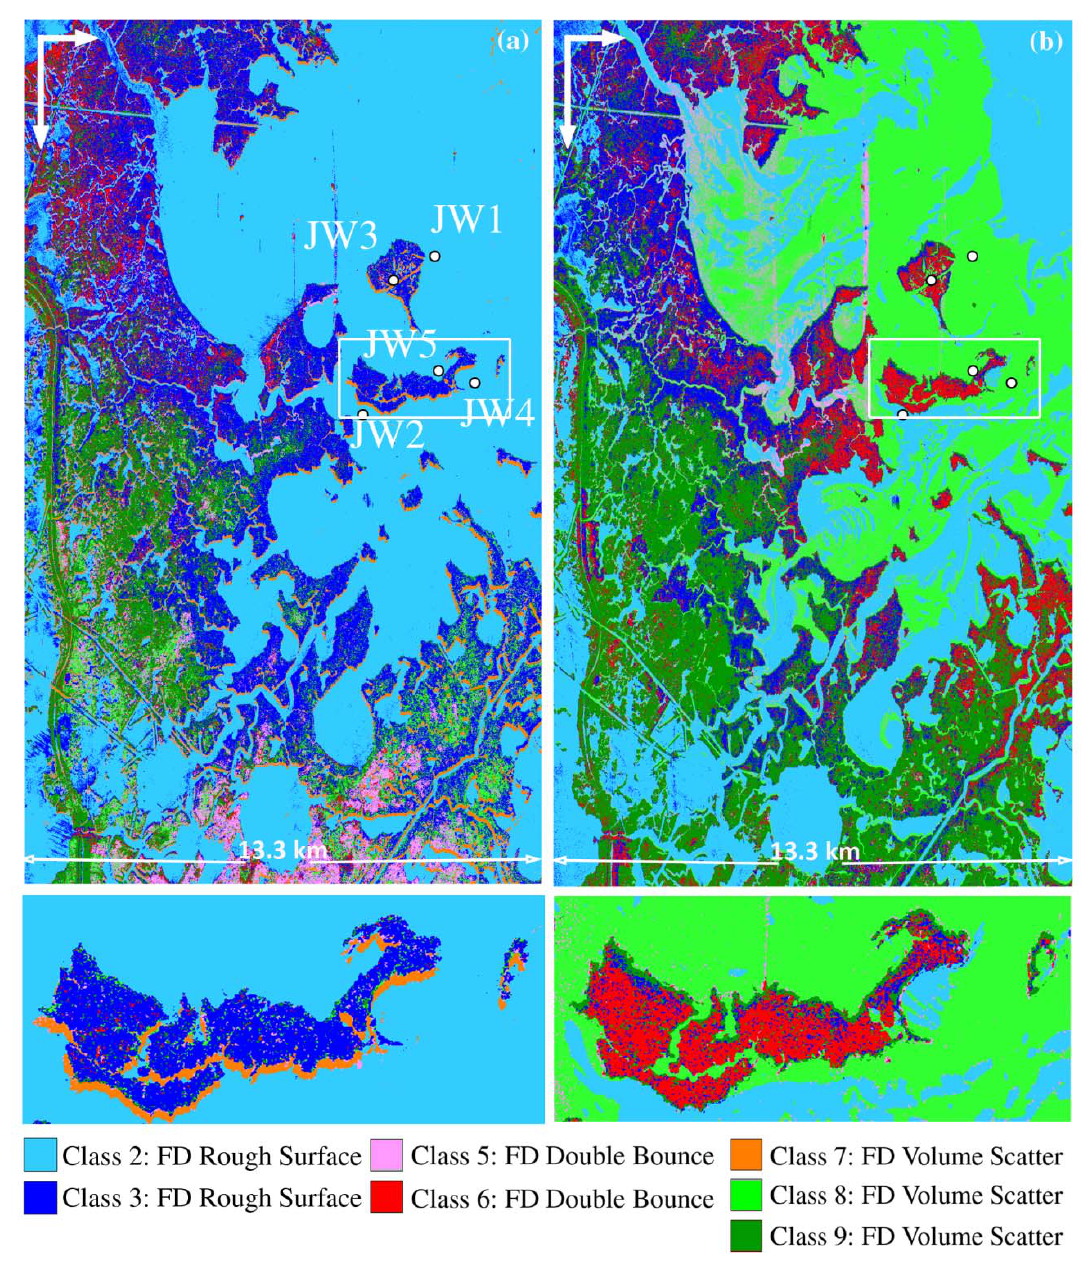
Figure 11. Results of the Wishart classification initiated with FD classes (see Figure 9) of the 2009 (a) and 2010 (b) MLC of the MRD flight lines. Note the wind-shadow water class on the 2009 inset. JW1-JW5 labels locate sample sites used for polarimetric signatures creation. The same color reference table was used in the 2009 and 2010